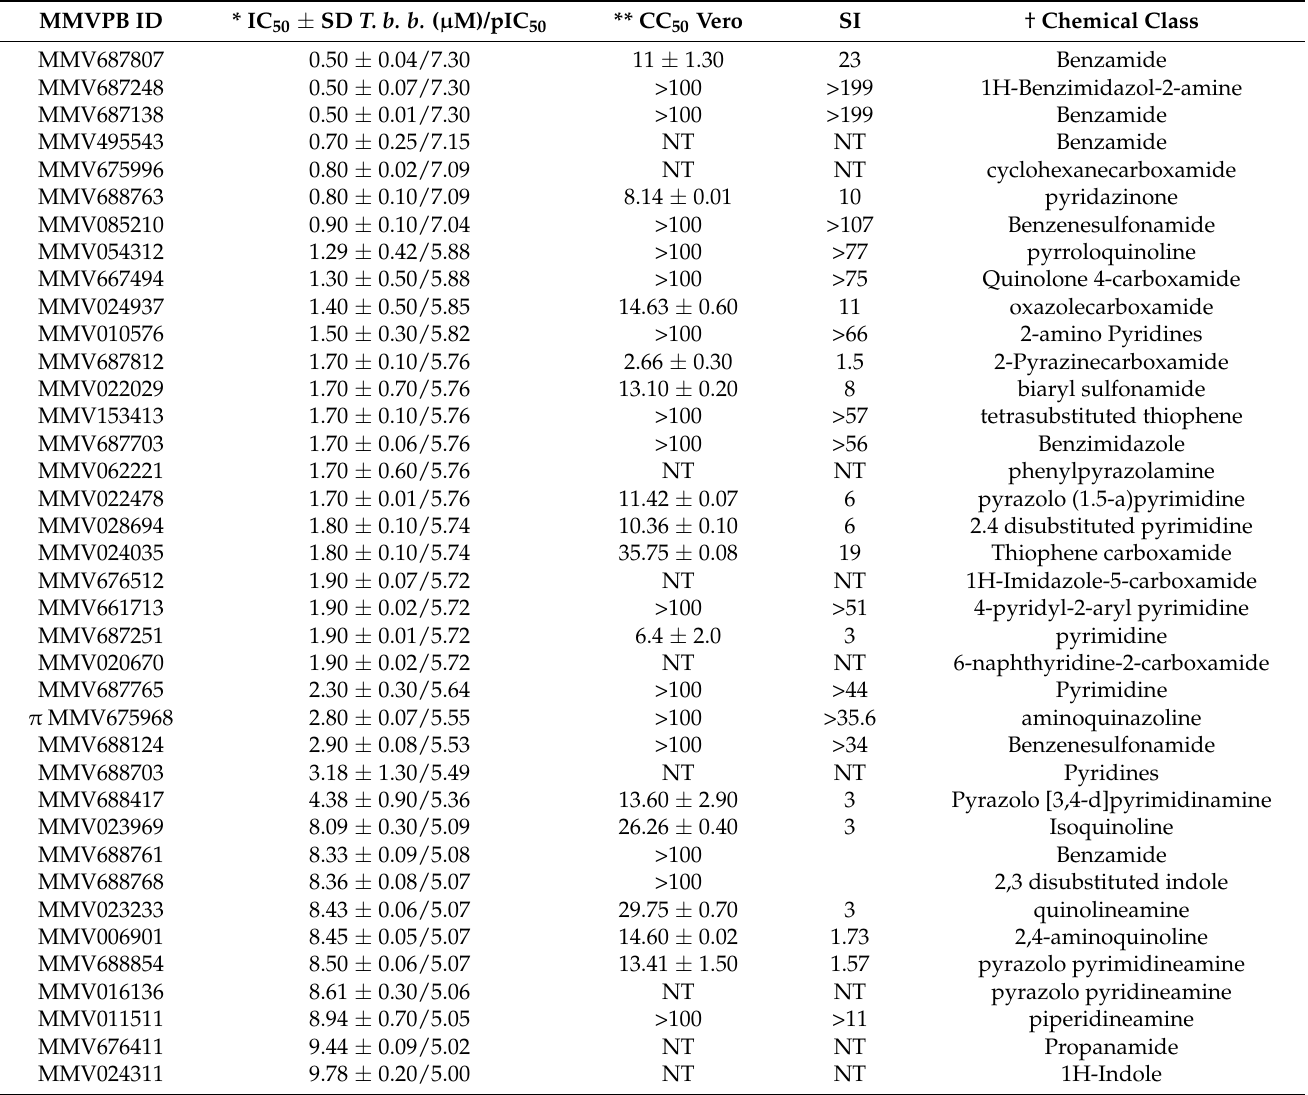
Table 3. In vitro antitrypanosomal and cytotoxic activities of the 38 MMVPB compounds with known potency against other